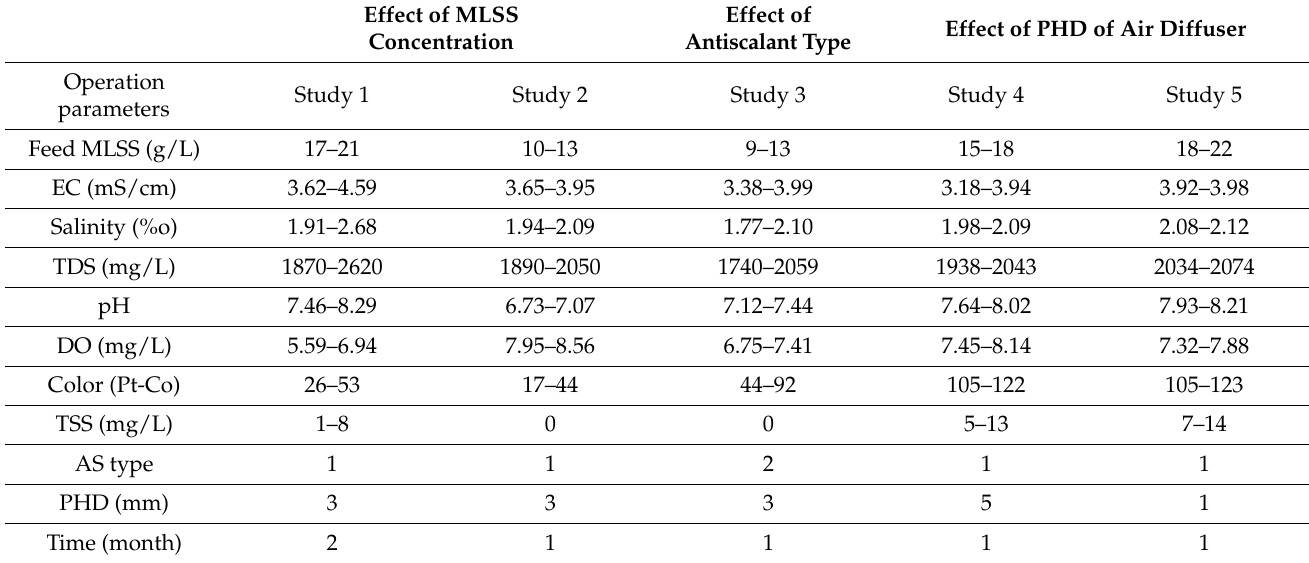
Table 4. Summary of the quality analyses of completed tests with pilot MBR